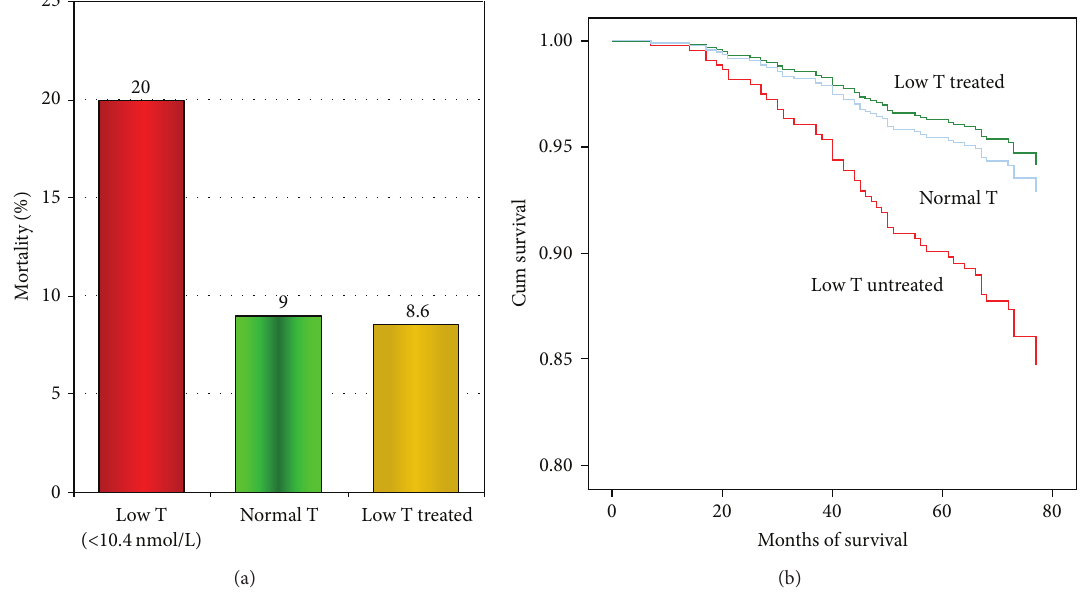
Figure 1: Low testosterone predicts increased mortality and testosterone therapy improves survival in 587 men with type 2 diabetes (mean follow-up: 5.8 years) Muraleedaran et al.